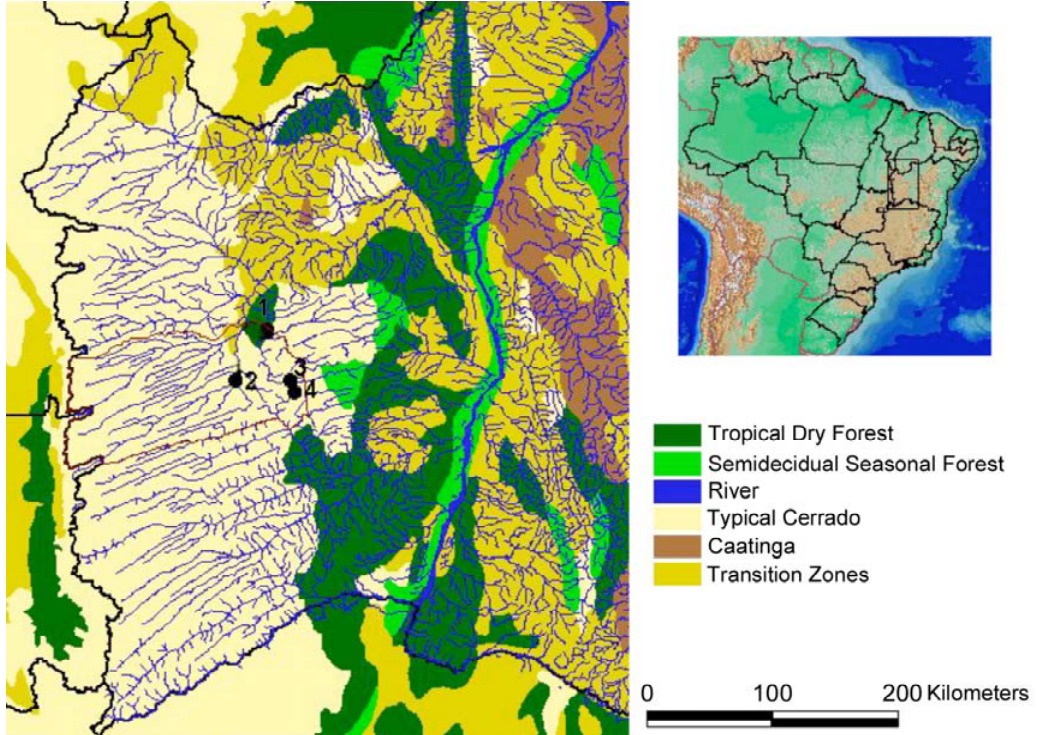
Figure 1. Sampled sites from the municipality of São Desidério, in western uplands of Bahia. Colors represent vegetation types (according to IBGE 2003). Numbers represent sampling sites: 1 - Parque Municipal Lagoa Azul and sorroundings; 2 - v ereda do Anastácio ; 3 - povoado de Campo Grande ; 4 - temporary ponds at the municipalities of São Desidério and Correntina